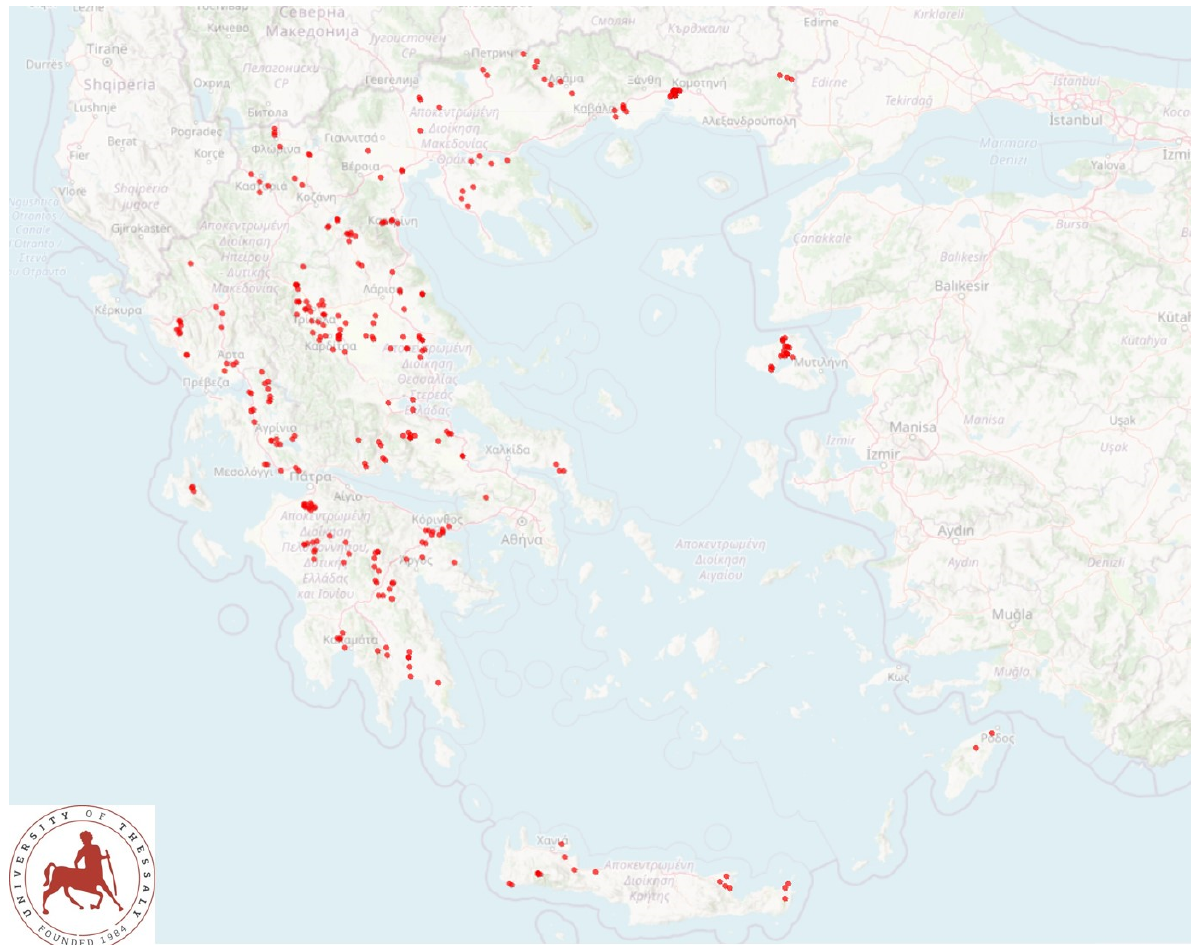
Figure 1. Location of 325 sheep flocks around Greece, which were visited for bulk-tank milk sampling.